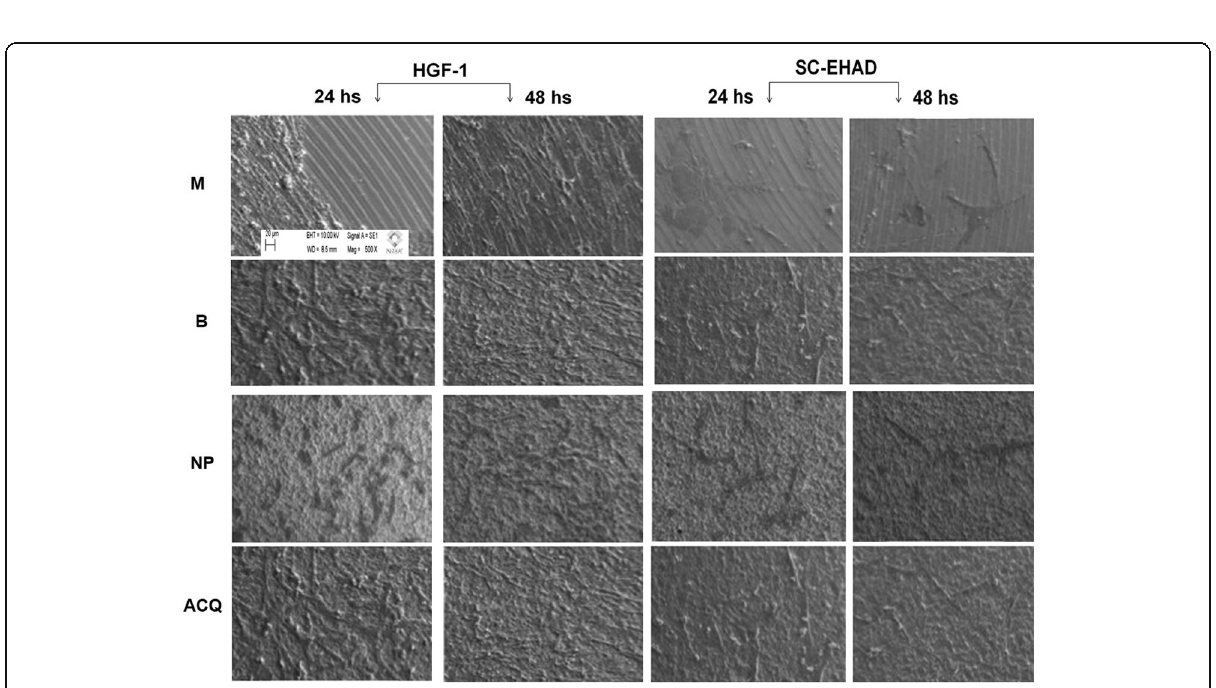
Fig. 4 SEM photomicrographs of HGF and SC-EHAD cell adhesion and proliferation. SEM images of HGF-1 and BG-1 cells cultivated on M, B, N,P and ACQ surfaces after 24 and 48 h of culture (× 500